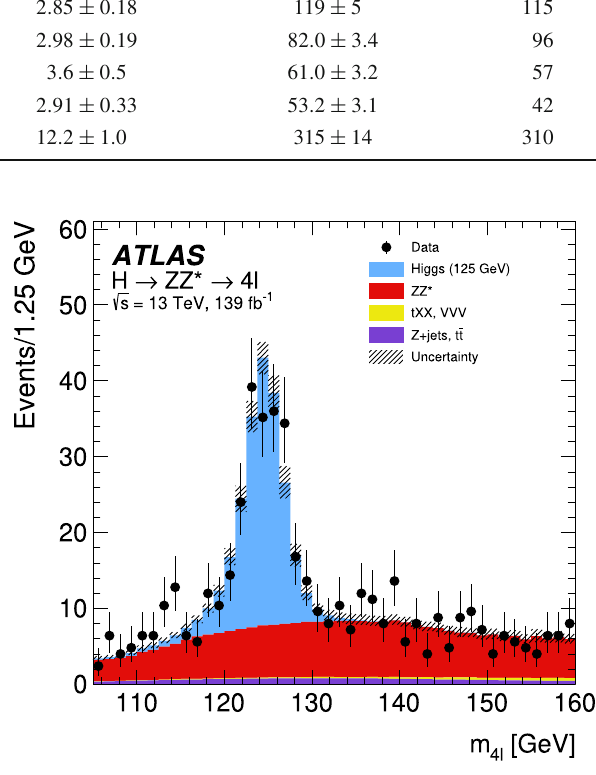
Fig. 2 Theobservedandexpected(pre-fit)inclusivefour-leptoninvari- ant mass distributions for the selected Higgs boson candidates, shown √ foranintegratedluminosityof139fb − 1 andat s = 13TeV.Theuncer- tainty in the prediction is shown by the hatched band, which includes the theoretical uncertainties of the SM cross section for the signal